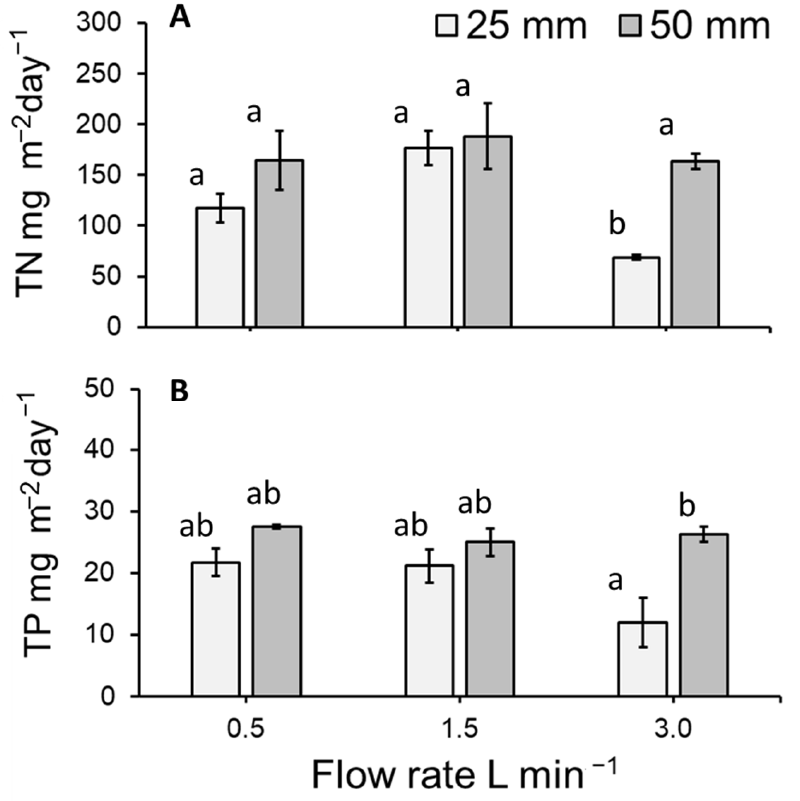
Figure 7. Mean (±SE) ( A ) TN removal per m 2 of Lemna minor per day (mg m − 2 day − 1 ), ( B ) TP removal per m 2 of L. minor per day (mg m − 2 day − 1 ) for plants cultivated on hydroponics medium at three flow rates and two medium depths over 7 days. Letters show statistical similarity within each panel ( p > 0.05).